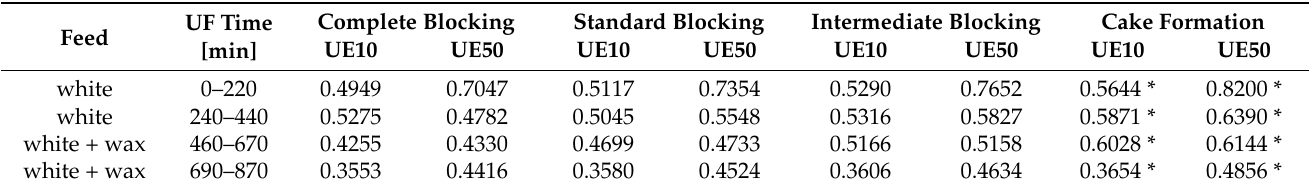
Table A2. Coefficient of determination (R 2 ) Hermia’s model. The UF process with the constant feed concentration (Figure 8).